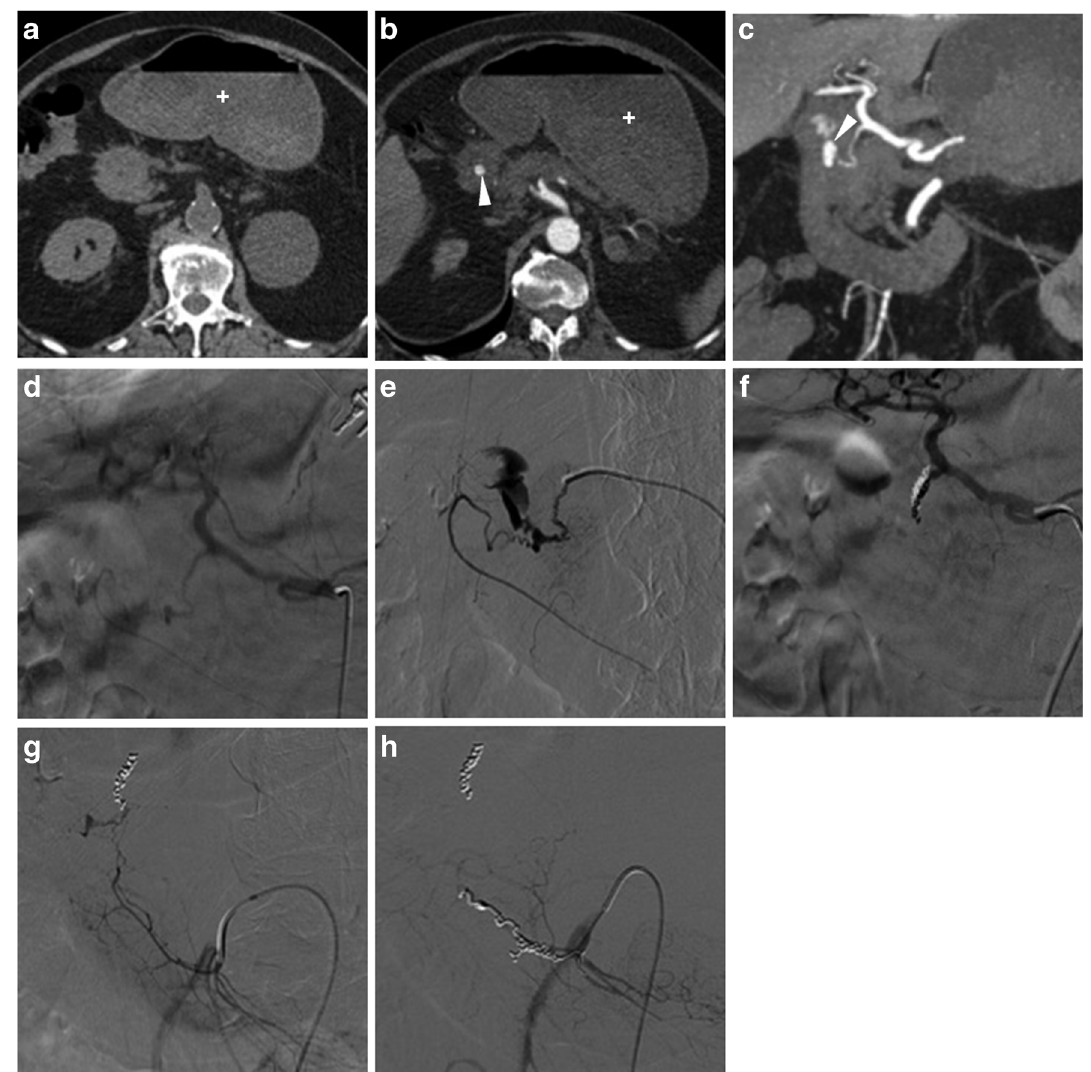
Fig. 10 A 63-year-old, haemodynamically unstable (blood pressure 70/ 40 mmHg) female with massive haemoptysis (haemoglobin 5